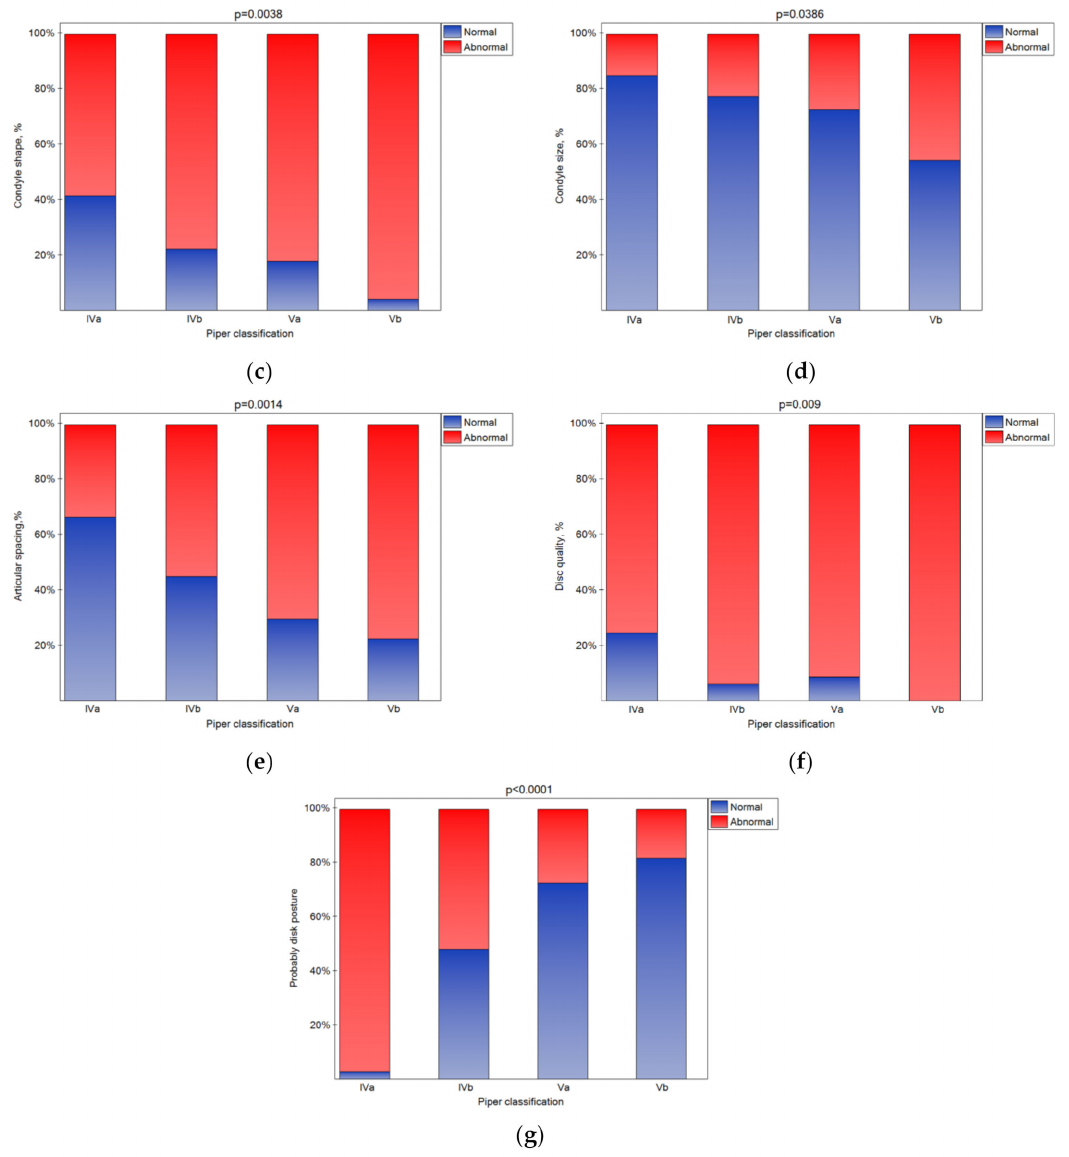
Figure 5. Impact of the Piper classification on the condylar translation ( a ), condyle cortex ( b ), condyle shape ( c ), condyle size ( d ), articular spacing ( e ), disk quality ( f ), and disk posture ( g ) (statistically significantly effect was for p < 0.05 level).